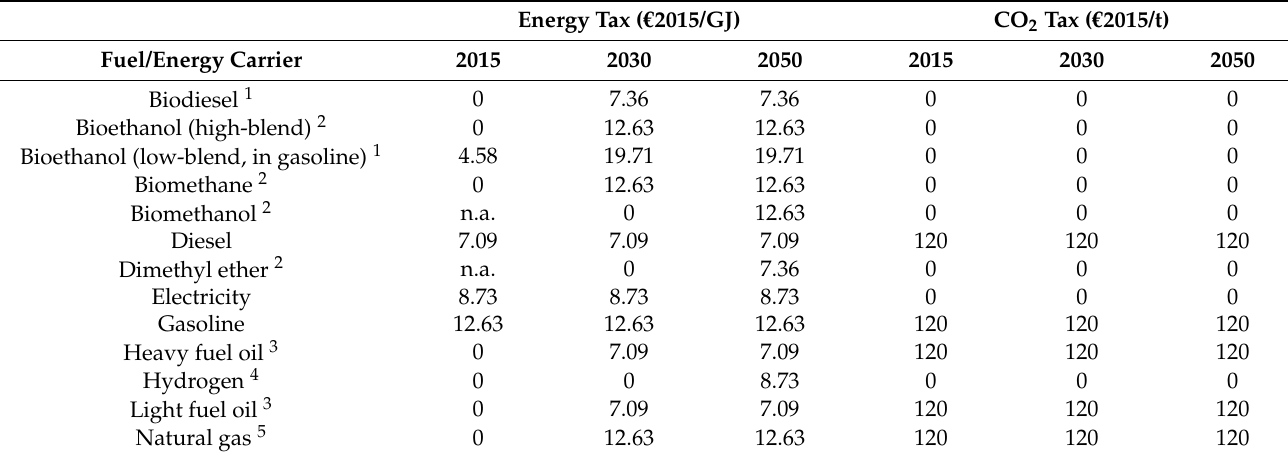
Table A5. Energy tax and CO 2 tax assumptions for each respective included fuel